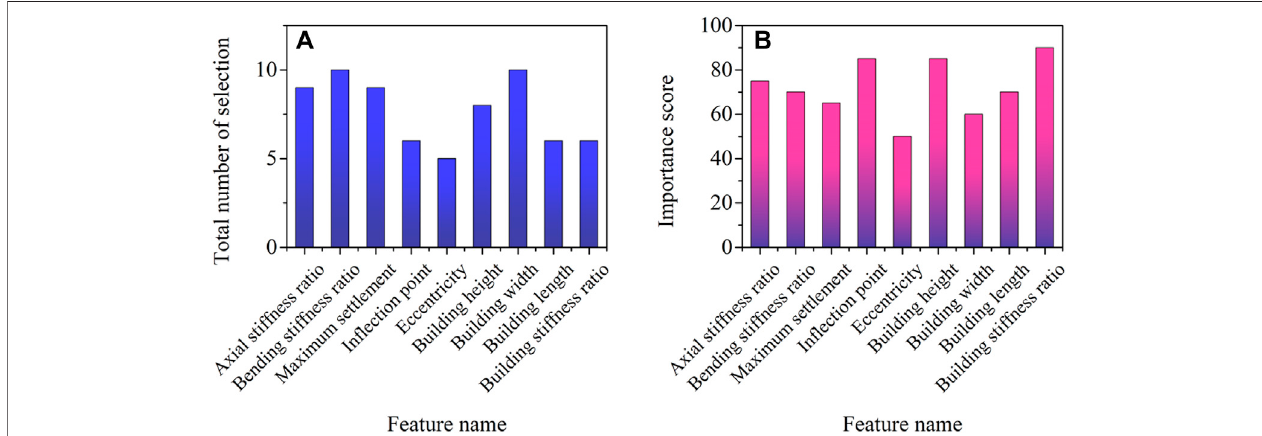
TABLE 2 | Predictive performance of building structural damage risk classi fi cation algorithms.